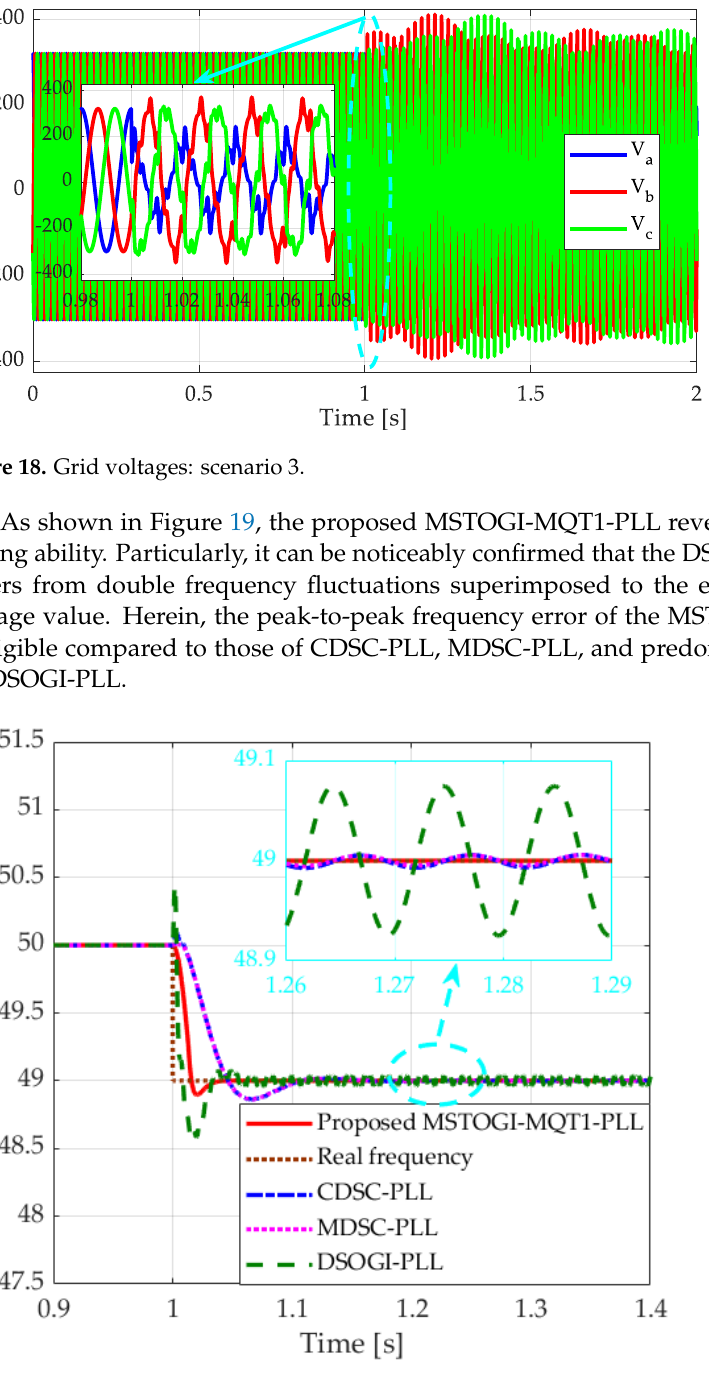
Table 2. Summary of results.